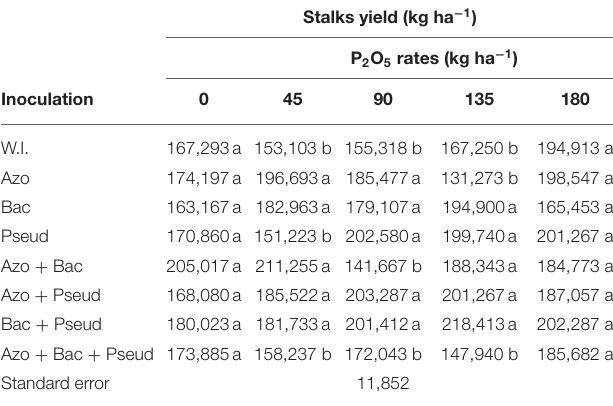
TABLE 10 | Interactions between different bacterial inoculations and P 2 O 5 doses for stalks yield in sugarcane crop. Stalks yield (kg ha − 1